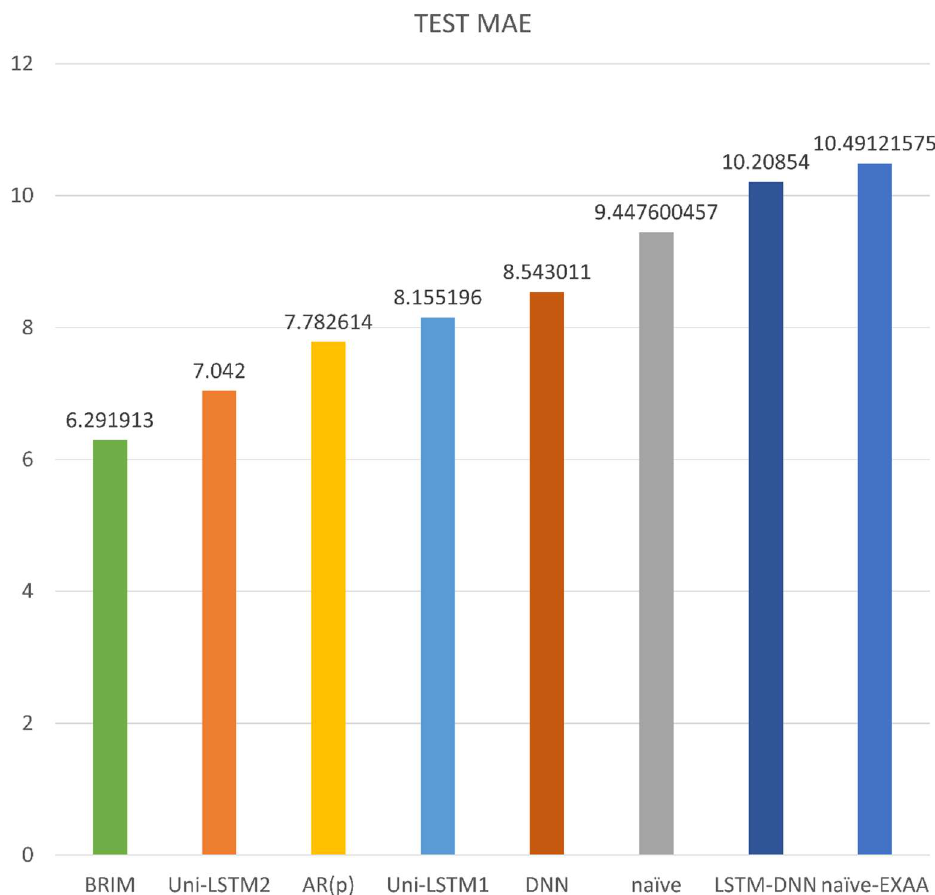
Figure 4. Comparison of the predictive performance of BRIM with benchmark schemes in the European Power Exchange (EPEX)-FR by means of mean absolute error (MAE).